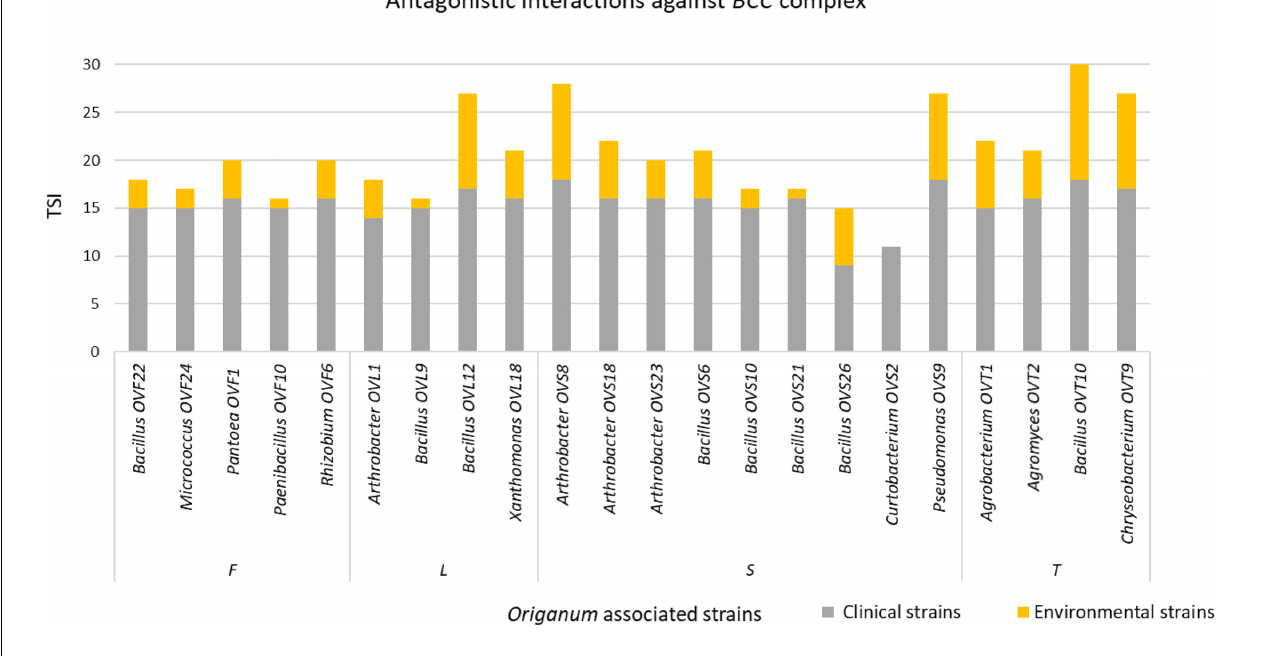
antibiotics tested, even at the highest concentrations used. The high tolerance to both streptomycin and kanamycin, shown by tested strains, could be due to similar resistance